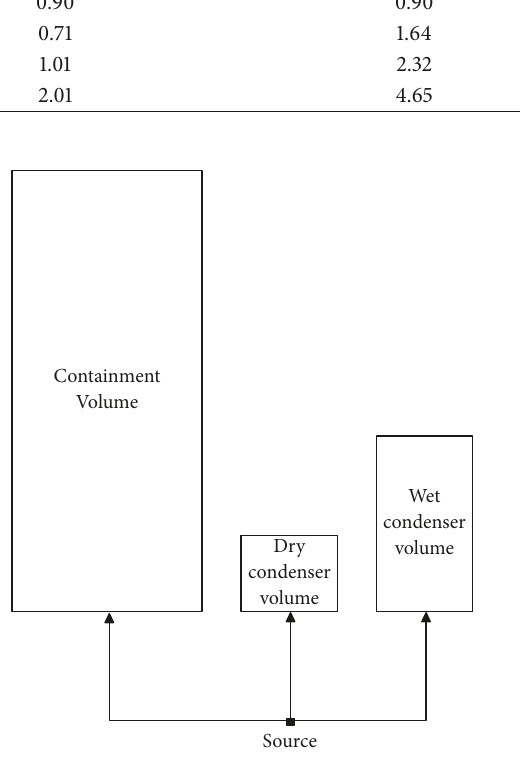
Figure 5: Nodalization of containment vessel, dry condenser, and wet condenser of Ph´ebus FPT3 experiment in ART Mod